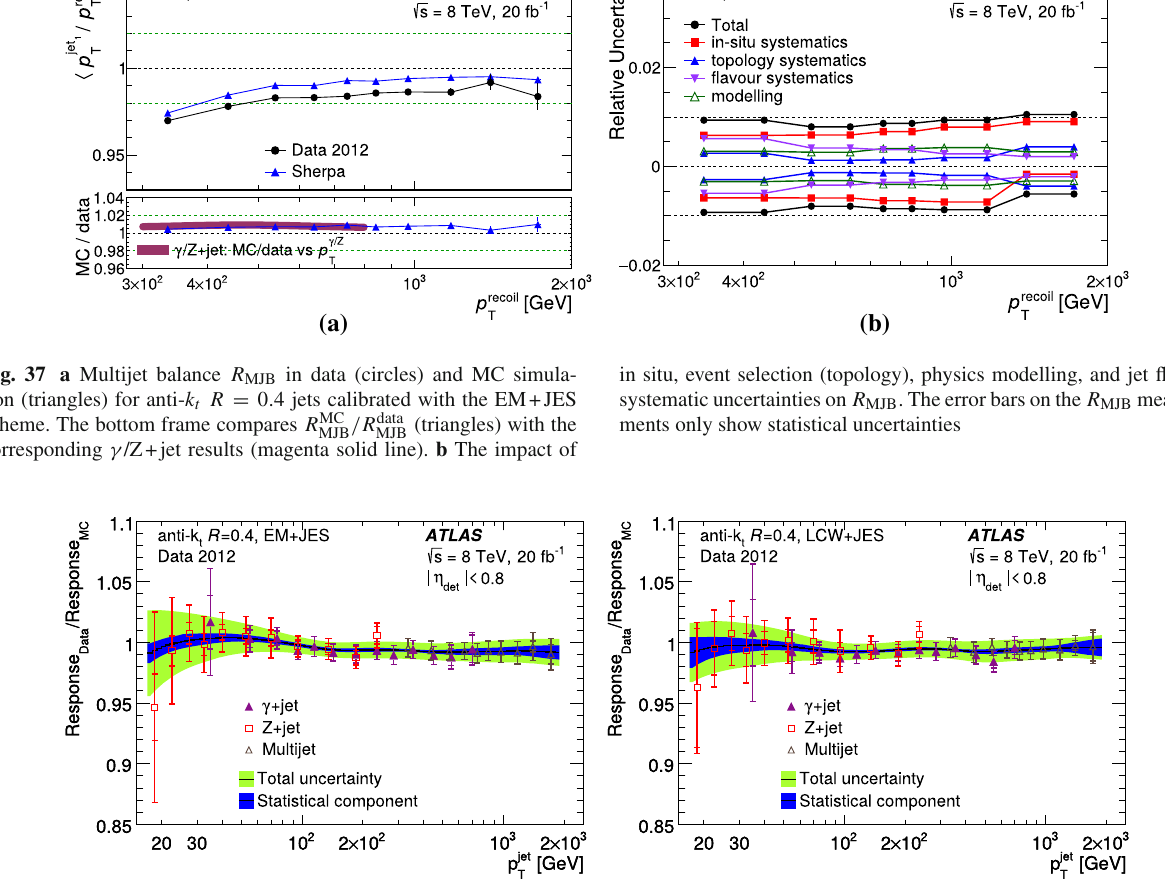
ment has two error bars: the smaller interval corresponds to the sta- tistical uncertainty, while the outer error interval corresponds to the total uncertainty. Also shown is the combined correction (line) with its associated total uncertainty (wider band) and statistical uncertainty (narrower band) as discussed in Sect.